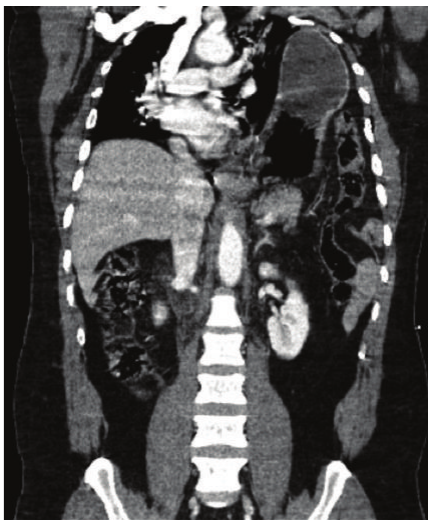
Figure 19: Signs of rupture of the diaphragm. Coronal MDCT reconstruction. A massive left diaphragmatic hernia with herniation ofthestomachandleftcoloncontentisseeninapatientwhosuffered a car accident. It decreases left pulmonary volume and shifts the mediastinum towards